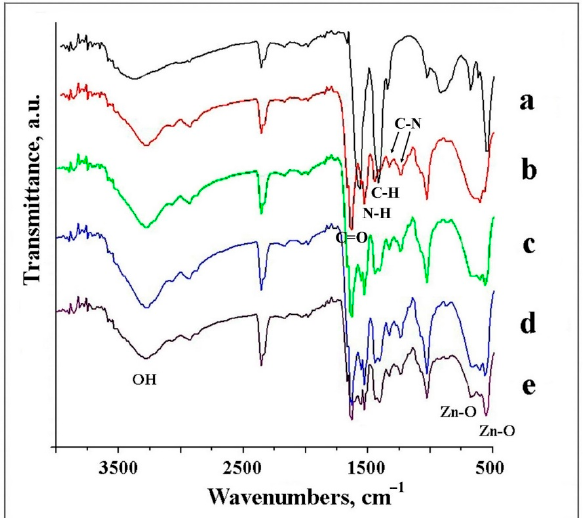
Figure 5. FTIR spectra of the samples: ZnO NPs ( a ), GNF ( b ), GNF@ZnO 2 h ( c ), GNF@ZnO 5 h ( d ) and GNF@ZnO 24 h ( e ).